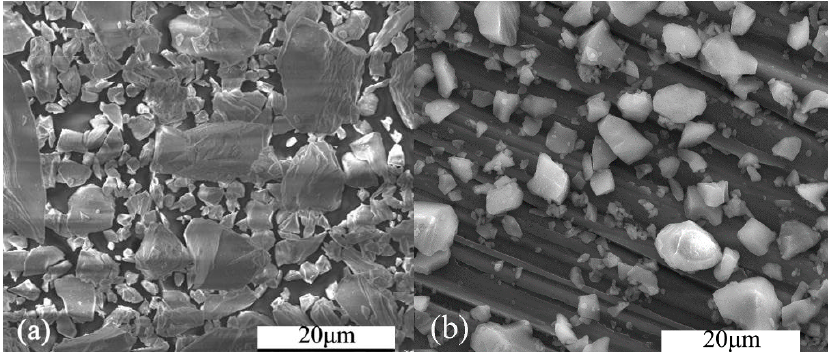
Figure 1. Morphologies of the original quartz powders ( a ) coarse powders with diameter of 10–40 μ m and ( b ) fine powders with diameter of 1–10 μ m.